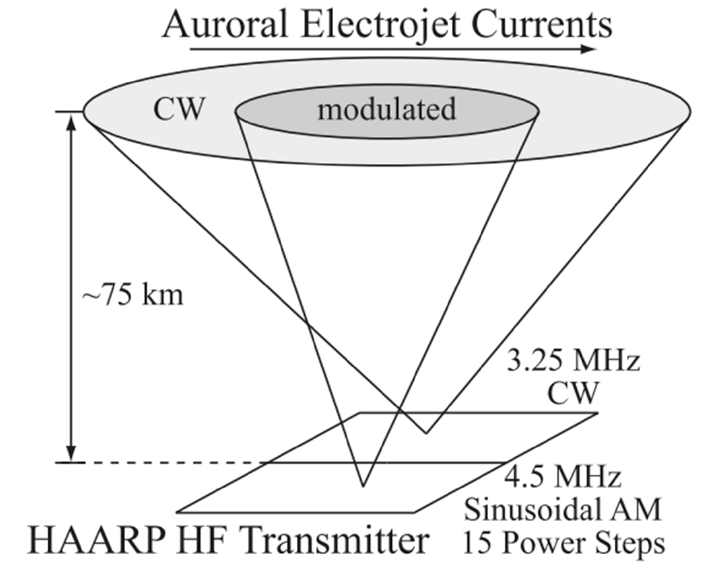
Figure 5. Schematic of the Dual-Beam HF heating experiment. The 3.25 MHz continuous wave (CW) beam is broader than the 4.5 MHz modulated beam (reproduced with permission from Moore, R.C., Agrawal, D., ELF/VLF wave generation using simultaneous CW and modulated HF heating of the ionosphere; published by John Wiley and Sons, 2011 [40]).